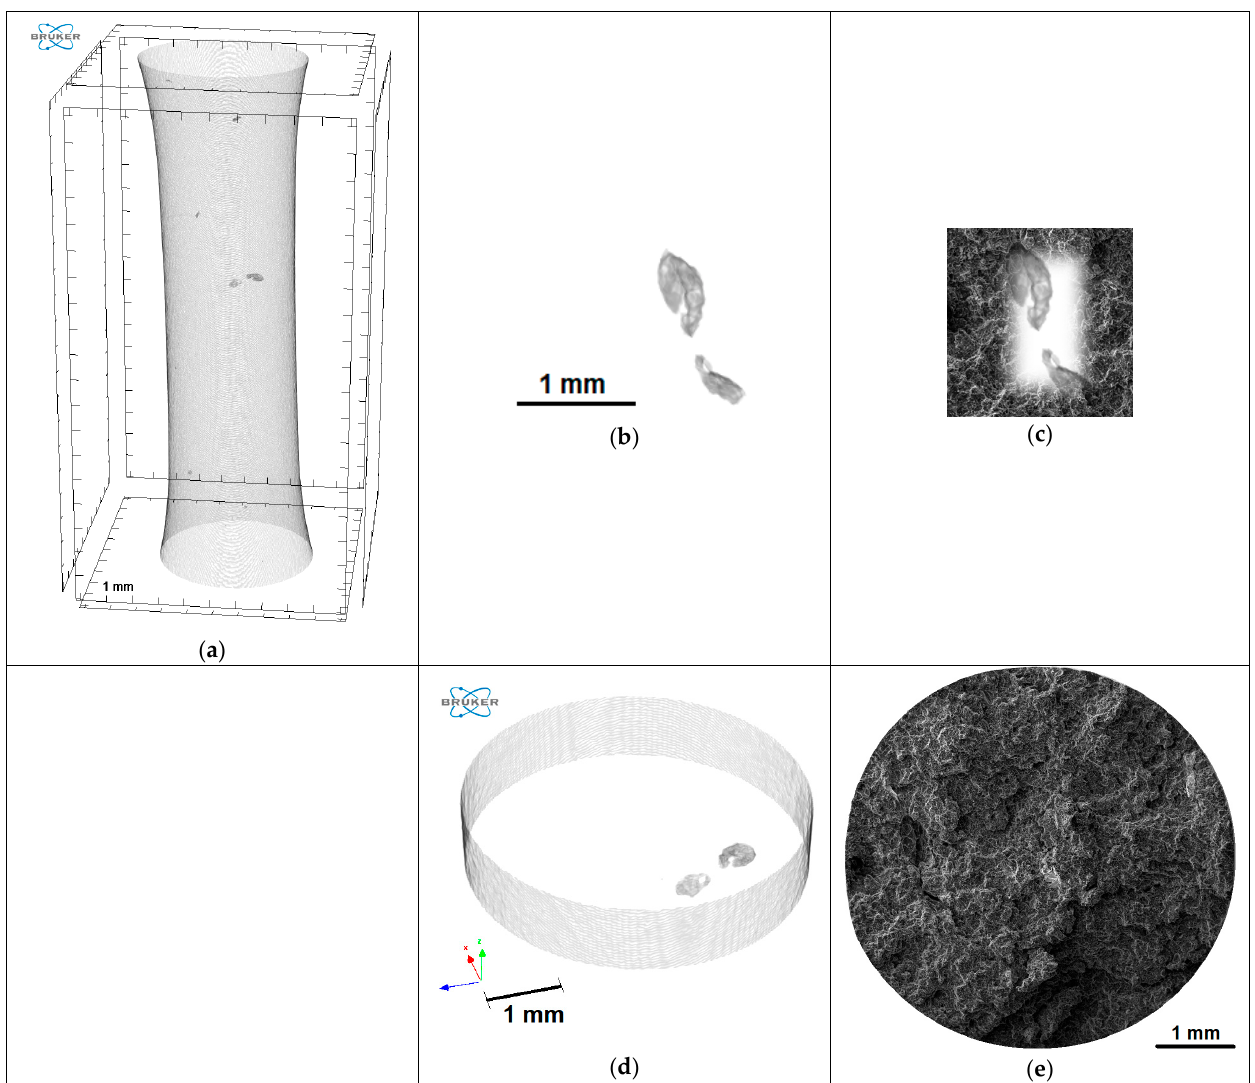
Figure 9. Gauge length of sample before loading (first R = − 1, 2 × 10 6 cycles at 50 MPa run out followed by tensile test) in µ-CT analysis ( a , b , d ) and fractured surface by SEM analysis ( e ) with highlighted large shrinkage cavity in ( c ).